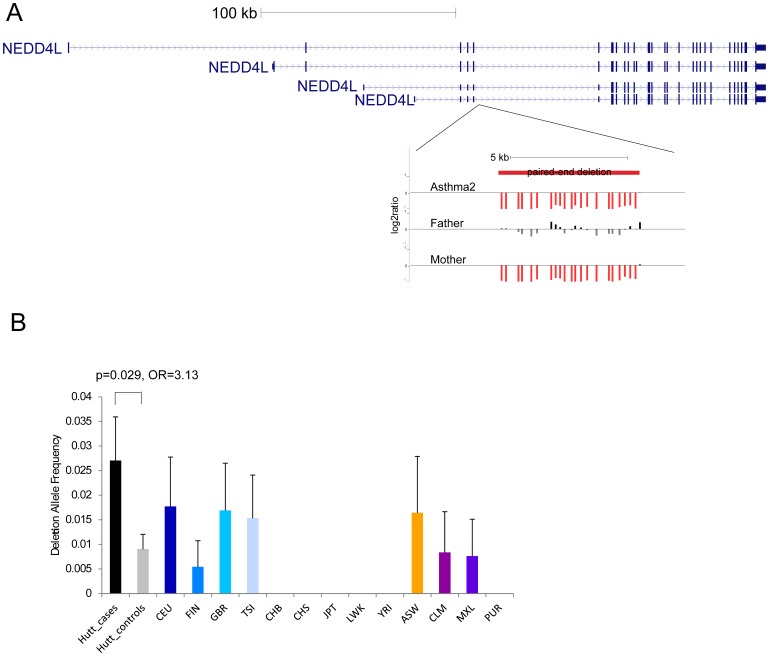
Identification of an intronic deletion in NEDD4L associated with asthma.(A) A representation of the location of the 6 kbp deletion. This deletion occurs in an intron shared by all reported transcripts of this gene (blue). The deletion was identified from paired-end sequence reads and validated by array CGH as shown for one of the sequenced trios. The log2 ratios of the probes in this region are shown as vertical bars with a log2 ratio of zero represented by the horizontal line. The red vertical bars in the child and mother indicate negative log2 ratios and confirm the deletion. (B) The frequency of this deletion in multiple populations is shown in the bar graph with the deletion allele frequency on the y-axis. The error bars represent the standard error on the allele frequency based on the binomial distribution. The Hutterite case (black) and control (gray) frequencies were determined by array CGH; the frequencies for the other populations are as reported by the 1000 Genomes Project.